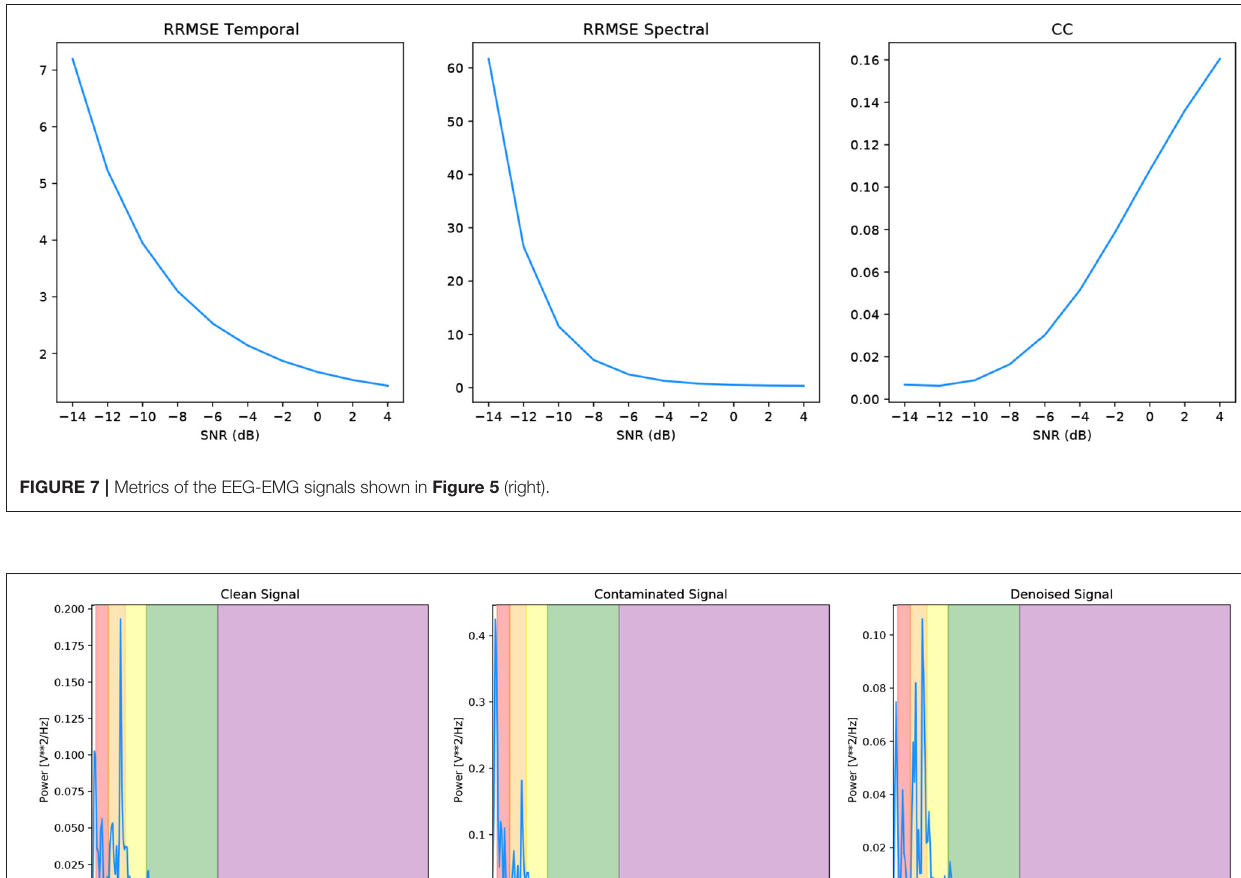
Frontiers in Neuroergonomics | www.frontiersin.org